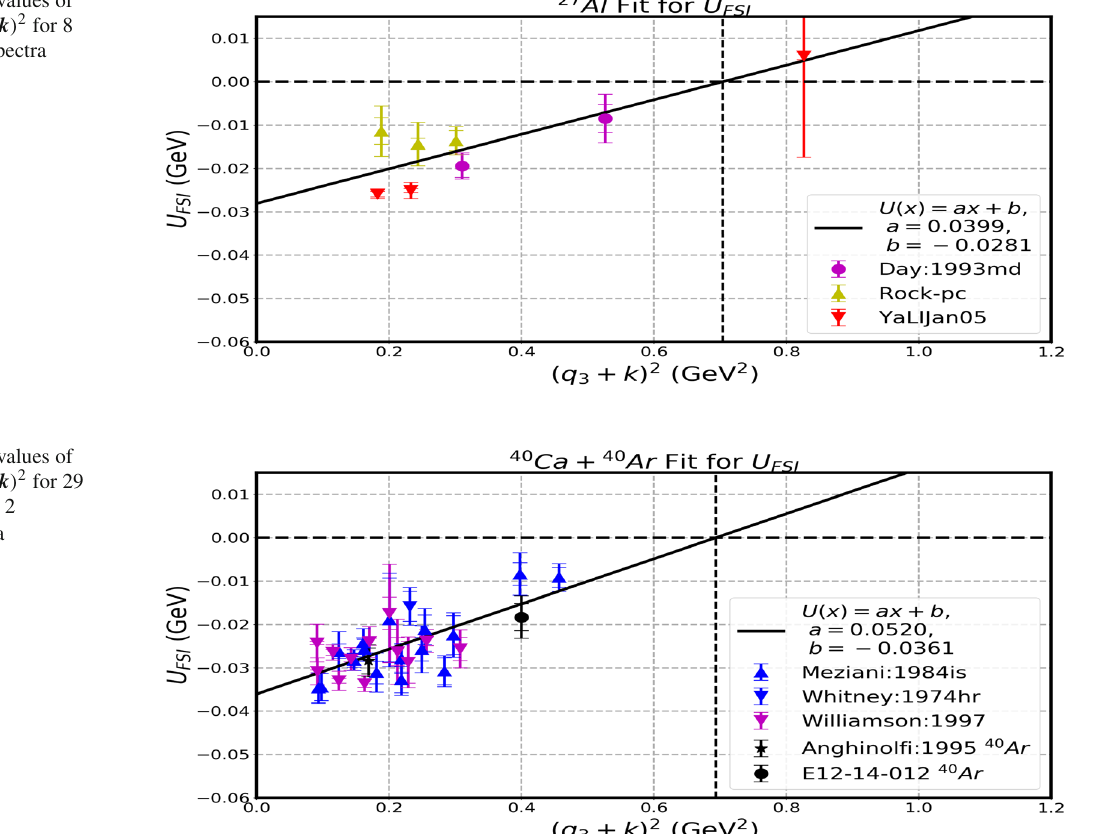
Fig. 18 Extracted values of U FSI versus ( q 3 + k ) 2 for 8